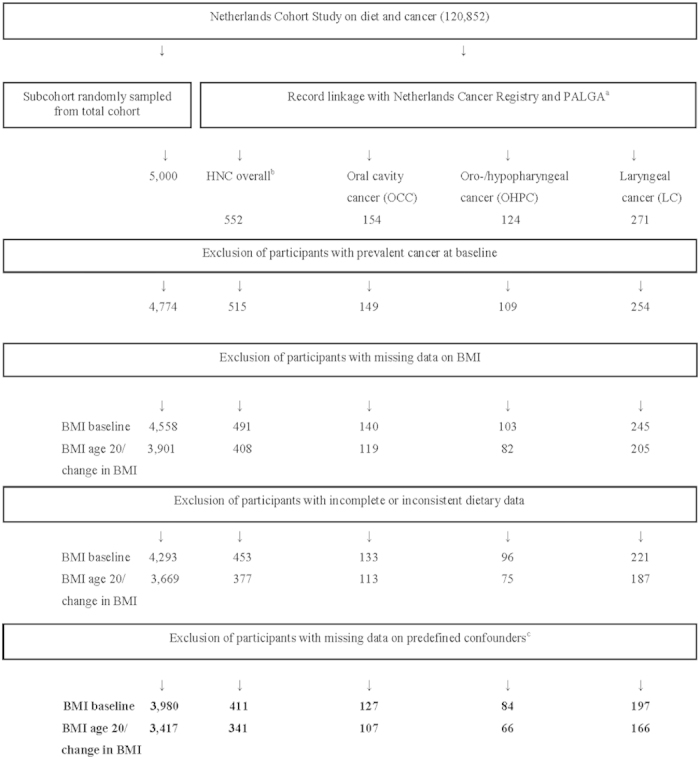
Flow diagram of number of subcohort members and cases on whom the analyses were based.aAbbreviation PALGA: nationwide network and registry of histopathology and cytopathology in the Netherlands. bOral cavity cancer; oro-/hypopharyngeal cancer; oral cavity, pharynx unspecified or overlapping cancer; laryngeal cancer. cThe predefined confounders were age (years), sex, alcohol consumption (grams/day), and cigarette smoking (status (never/former/current), number of cigarettes smoked daily, and number of smoking years).